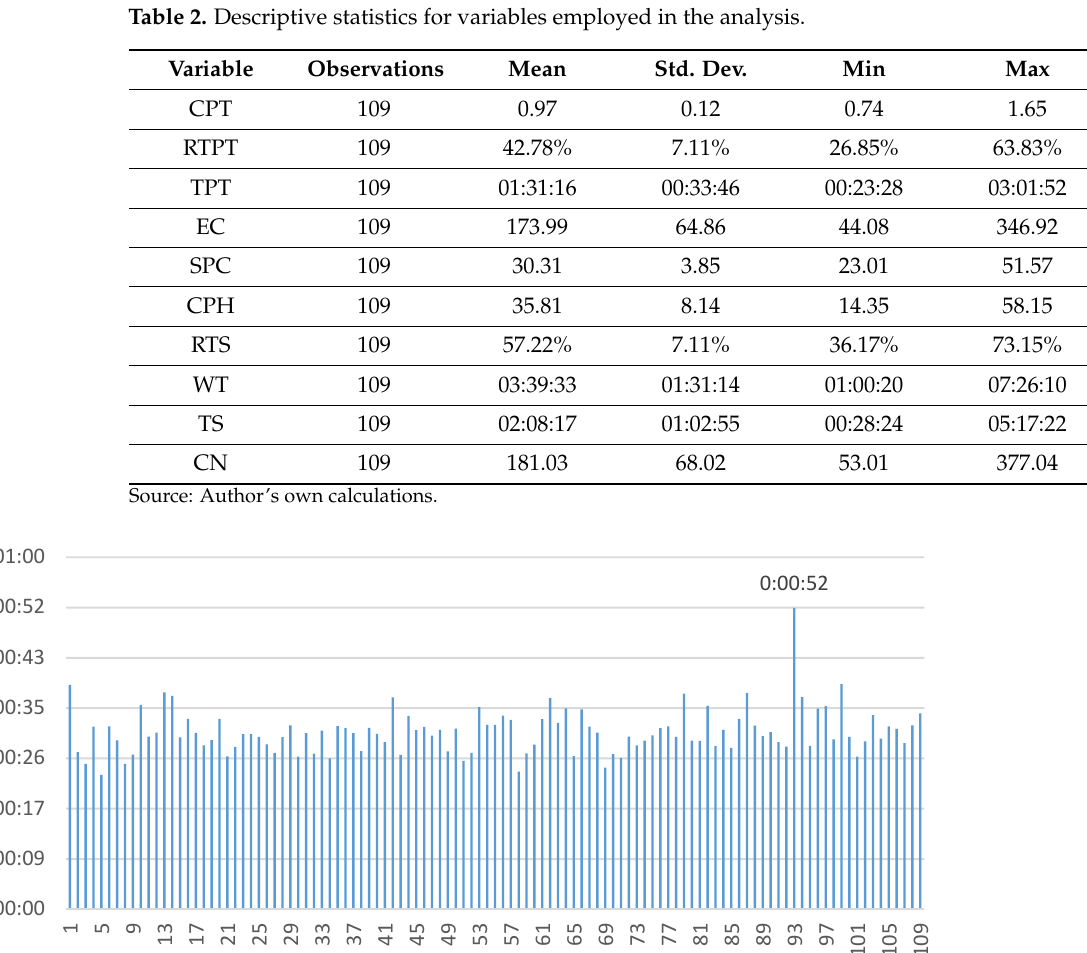
Figure 1. The average payment time per customer. Source: Author’s elaboration based on empirical studies. Table 2. Descriptive statistics for variables employed in the analysis.